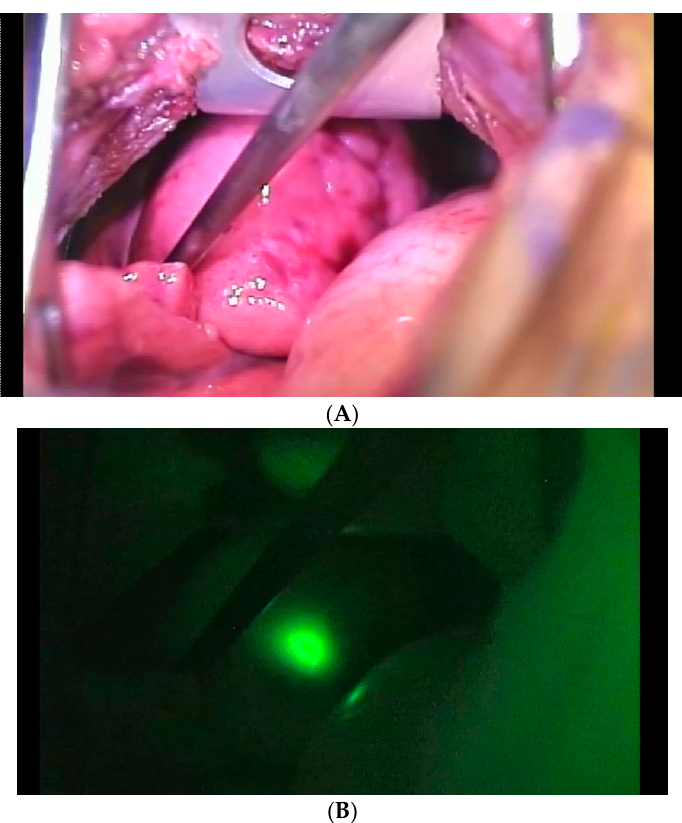
Figure 4. Indocyanine green (ICG) aids in localization of pulmonary metastases. The lesion is indistinguishable from normal lung parenchyma ( A ), but ICG fluorescence clearly delineates the metastatic lesion ( B ).